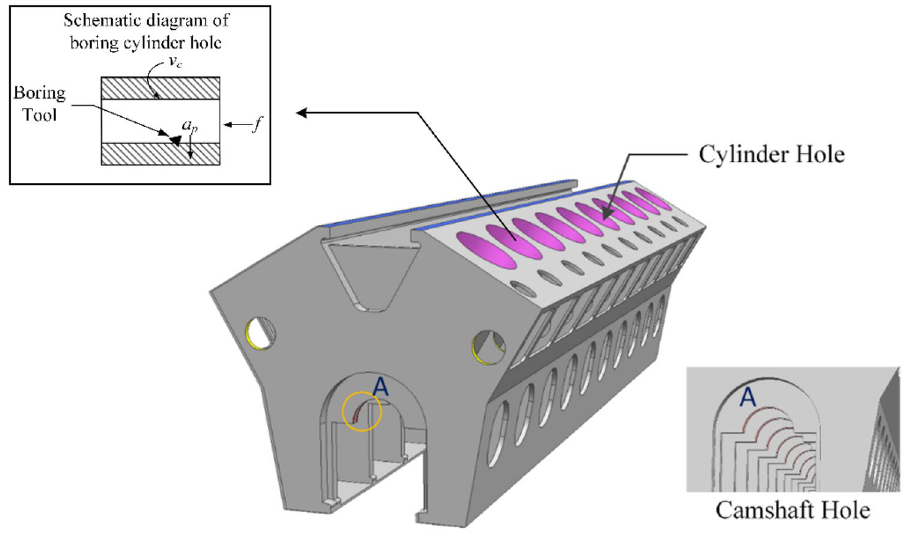
Figure 1. Three-dimensional simplified model of the diesel engine